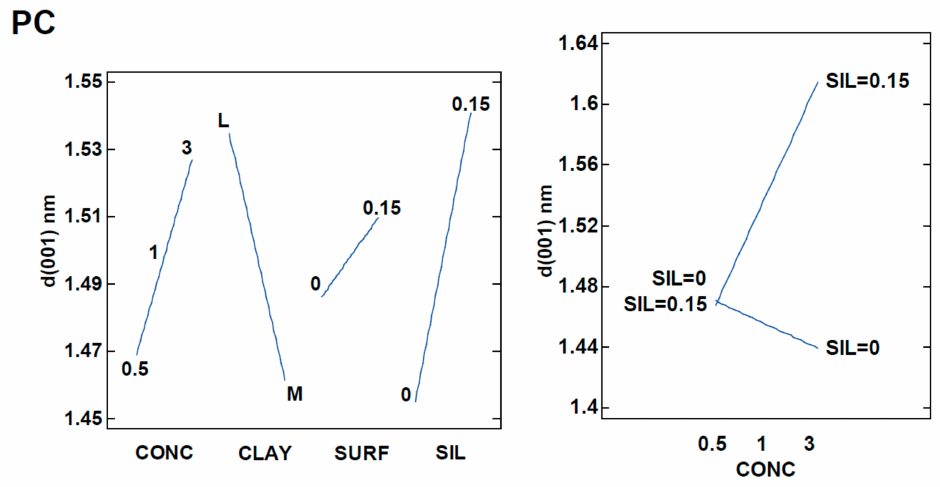
Figure 16. Main effects and interactions plots from the d(001)nm response in the PC pigments. Finally, the results showed the importance of using a surfactant at the maximum PE concentration to increase the dye loaded onto the nanoclay structure, which also occurs for other examples with laminar nanoclays [54]. However, silane was not significant at a high concentration, but was significant at a lower concentration. Under these conditions, silane improved PE adsorption in the nanoclay structures. To achieve the maximum d 001 distance in M, the best conditions were achieved by using the maximum PE concentration. With L, the maximum separation was found at the minimum PE concentration using the silane additive (Figure